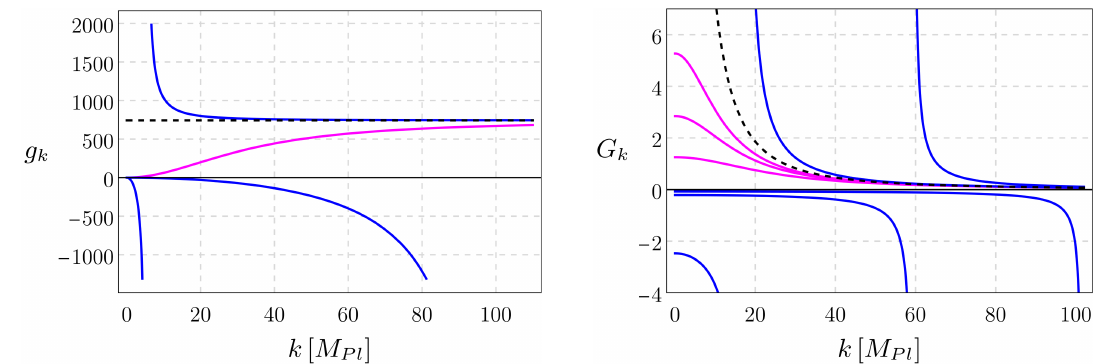
Figure 2 . Running dimensionless (left panel) and dimensionful (right panel) Newton coupling in d = 3 , for various initial conditions. The black-dashed lines indicate the position of the NGFP g ∗ . There are three types of RG trajectories. Trajectories with g NGFP at high energies but diverge in the IR. Trajectories with g energies and attain the GFP in the IR. Finally, trajectories with 0 < g the NGFP in the UV and the GFP in the IR. Clearly, the first two classes of trajectories (depicted as blue lines in both plots) are unphysical, while the only phenomenologically viable trajectories are those connecting the NGFP with the GFP (magenta lines), since they allow for a finite, non-zero dimensionful Newton coupling in the IR